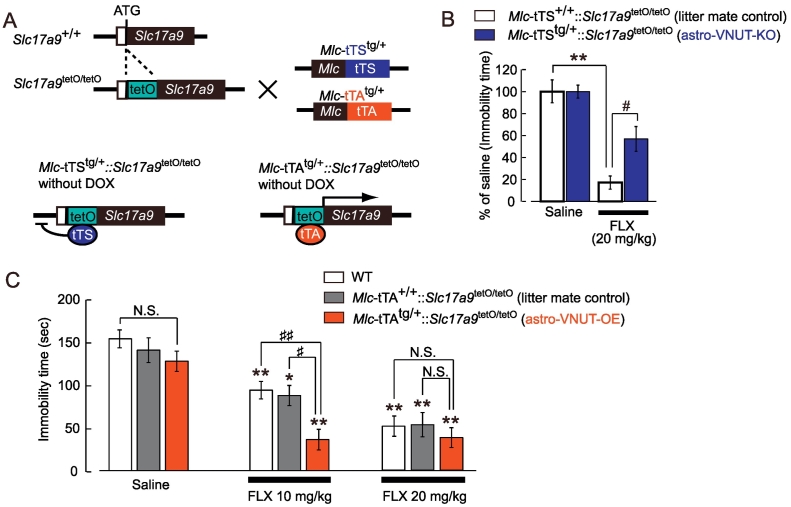
Astrocytic modulation of anti-depressive effects depends on VNUT expression.(A) Schematic diagram of astrocyte-specific tTS-mediated knockout (KO) and tTA-mediated overexpression (OE) systems. Mlc1-tTS; astrocyte-specific Mlc1 promoter drives the expression of the tetracycline-controlled transcriptional silencer (tTS). Mlc1-tTA; Mlc1 promoter drives the expression of the tetracycline-controlled transcriptional activator (tTA). TetO-Slc17a9 contains a tet operator (tetO)–regulated VNUT gene, i.e., Slc17a9. By crossing tetO-Slc17a9 with either Mlc1-tTS or Mlc1-tTA, we generated Mlc-tTStg/+::Slc17a9tetO/tetO, an astrocyte-specific VNUT-KO mouse (astro-VNUT-KO), Mlc-tTAtg/+::Slc17a9tetO/tetO, an astrocyte-specific VNUT OE mouse (astro-VNUT-OE), and Mlc-tTA+/+::Slc17a9tetO/tetO, their littermate control mouse (littermate control) whose VNUT expression is the same as WT. (B and C) Anti-depressive effect of FLX in astro-VNUT-KO mice (B) and astro-VNUT-OE mice (C). Mice were administered saline or FLX (10 or 20 mg/kg, p.o.) for 3 weeks and TST was performed. Data show the mean ± SEM of immobility times obtained from at least 4 independent set of experiments. *p < .05, **p < .01 vs. saline-treated group, #p < .05, ##p < .01 vs. littermate control, N.S., not significant.